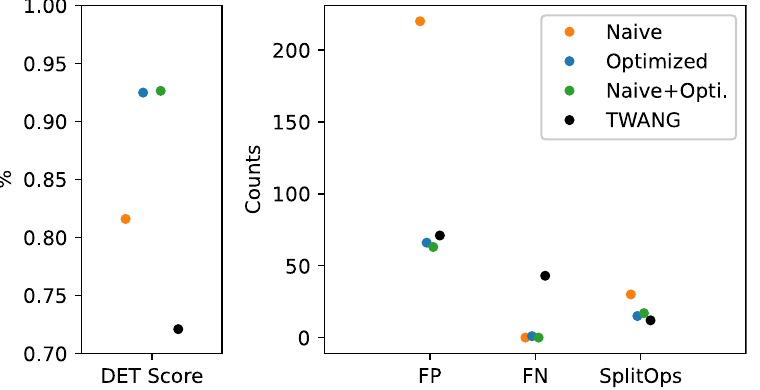
Fig 6. Performance of segmentation models on real data. The models are trained on naive and optimized image data. The left figure shows the detection accuracy (DET-Score), while the right figure shows the individual components of the metric: the number of false positive detections (FP), the number of false negative detections (FN), and the number of splitting operations (SplitOps).